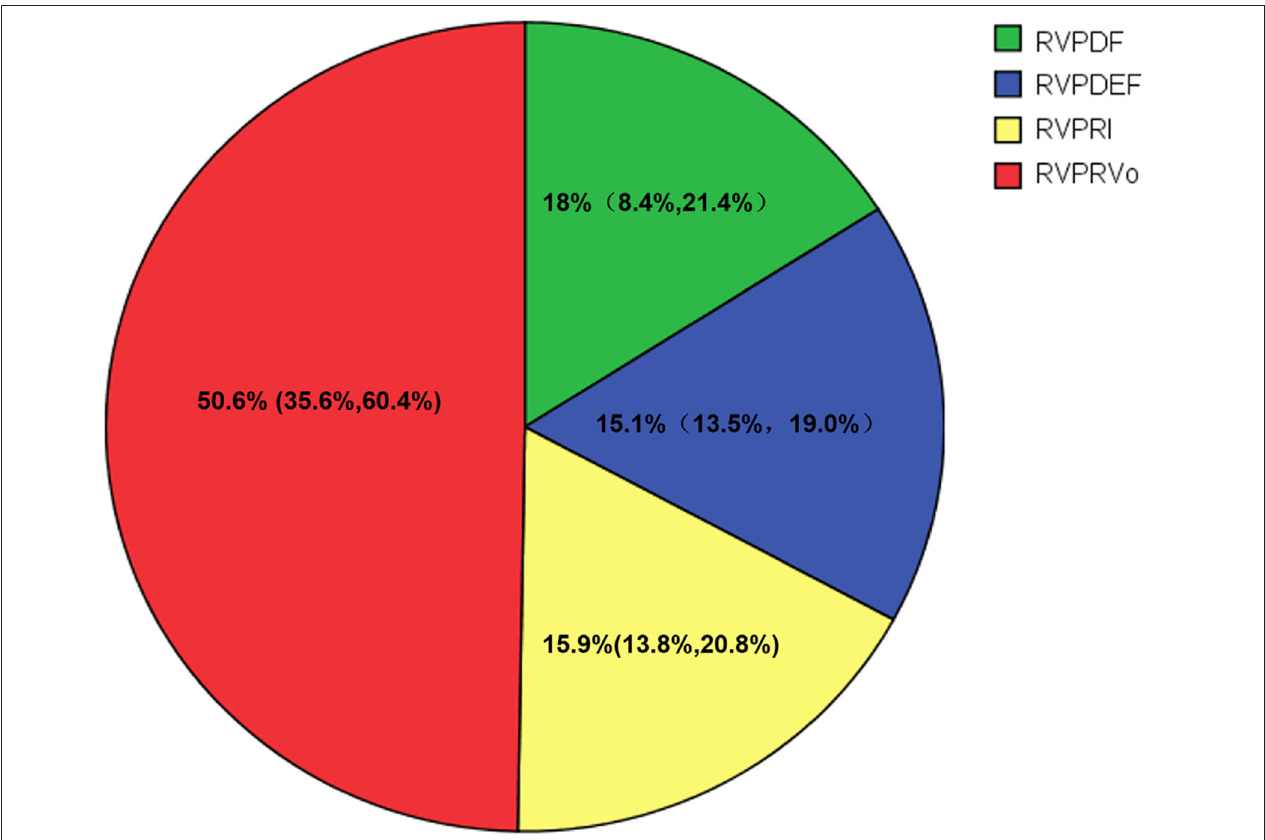
FIGURE 3 | Flow components by percentage of the right ventricular end-diastolic volume (RVEDV) for CTEPH. Green, the percent of direct flow (PDF); Blue, the percent of delayed ejection flow (PDEF); Yellow, the percent of retained inflow (PRI); Red, the percent of residual volume (PRVo).